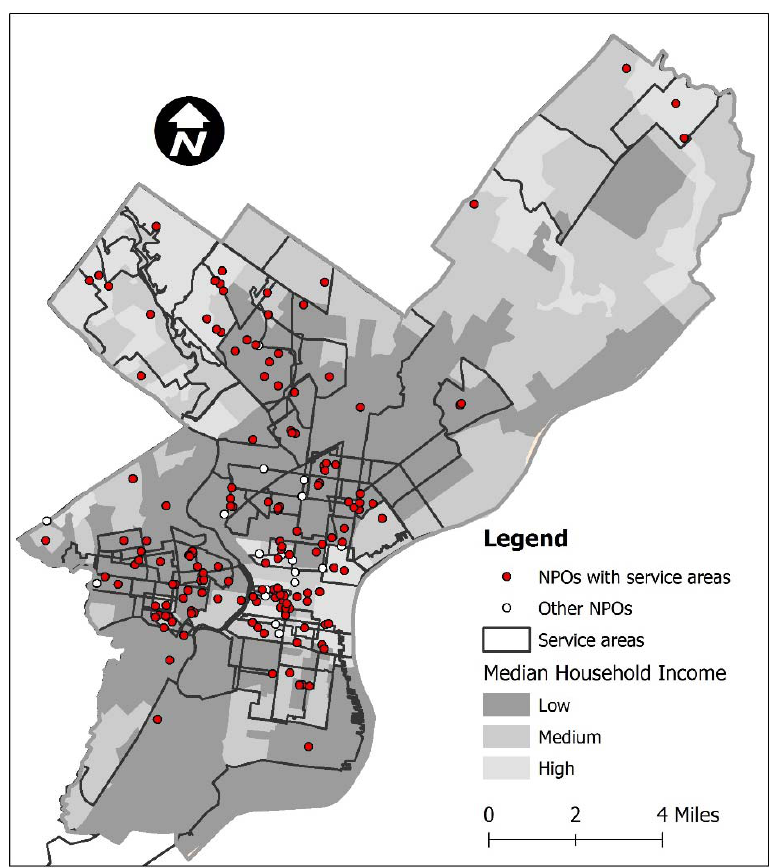
Figure 1. Map Showing the Point Locations of Philadelphia’s Food-Related Nonprofit Organizations (NPOs), 80 of Which Had Specific Service Area